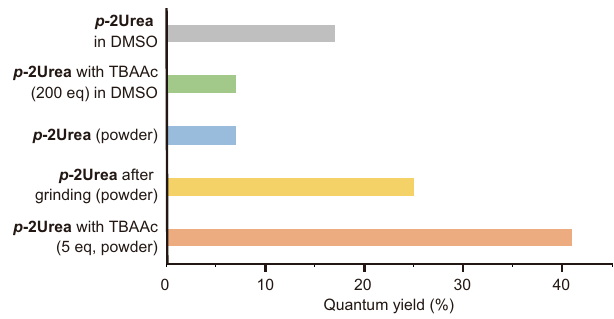
Fig. 5 Changes in fl uorescence quantum yield. Absolute fl uorescence quantum yields of p -2Ure a powder and p -2Urea – DMSO solution in the absence and presence of tetrabutylammonium acetate